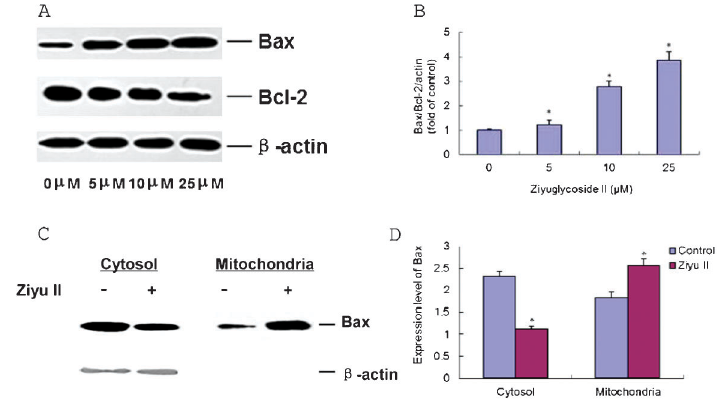
Figure 4. Effect of ziyuglycoside II on the expression of Bax and Bcl-2 protein in BGC- 823 cells after a 24-h treatment. A , Assessment of Bax and Bcl-2 expression levels in BGC-823 cells by Western blotting. B , Effect of ziyuglyco- side II on the ratio of values of Bax/Bcl-2. C , The subcellular expression level of the Bax protein in BGC-823 cells by Western blotting. D , Effect of ziyuglycoside II (Ziyu II) on subcellular distribu- tion of Bax. Data are reported as means±SD for n=3. *P , 0.05 vs control (Student t